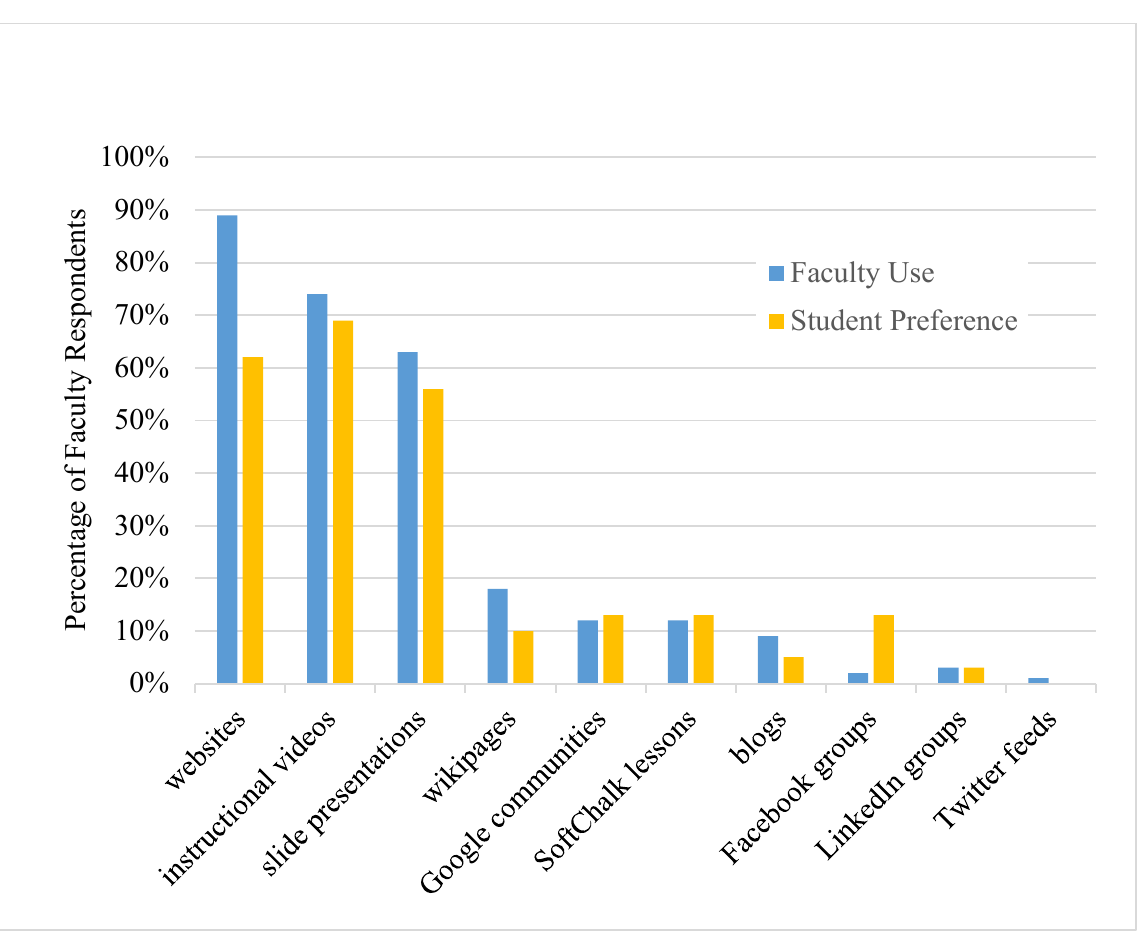
Figure 2. Faculty use and student preferences for technology